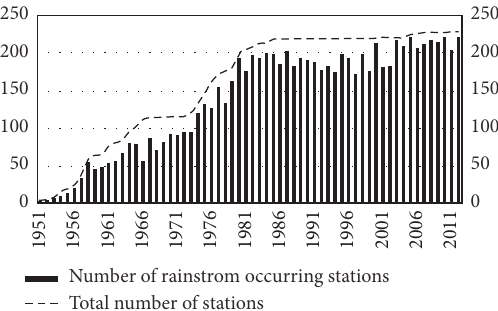
Figure 3: Rainstorm occurrence stations in different years.